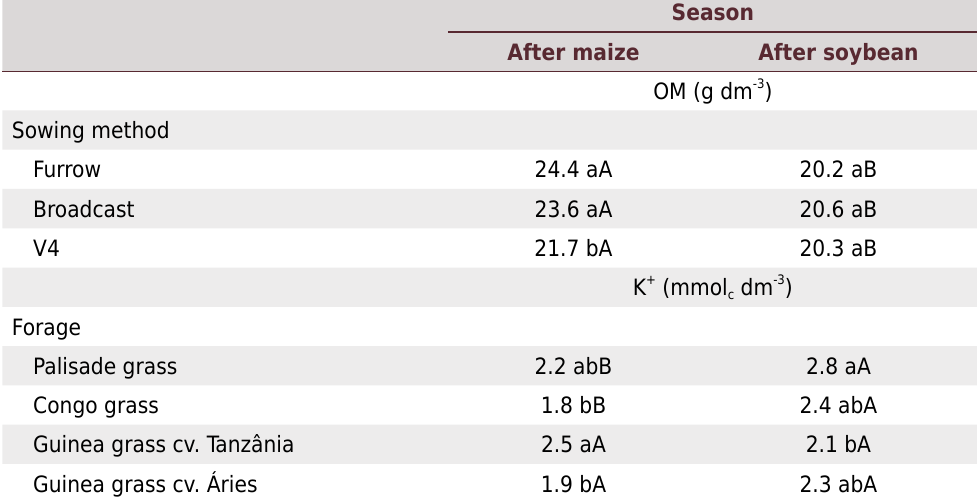
Table 5. Partitioning of significant interactions of organic matter (OM) and potassium (K + ) of the soil in the 0.0-0.2 m layer, after harvest of maize in monoculture or intercropped with forages sown in different methods and after the harvest of subsequent soybean